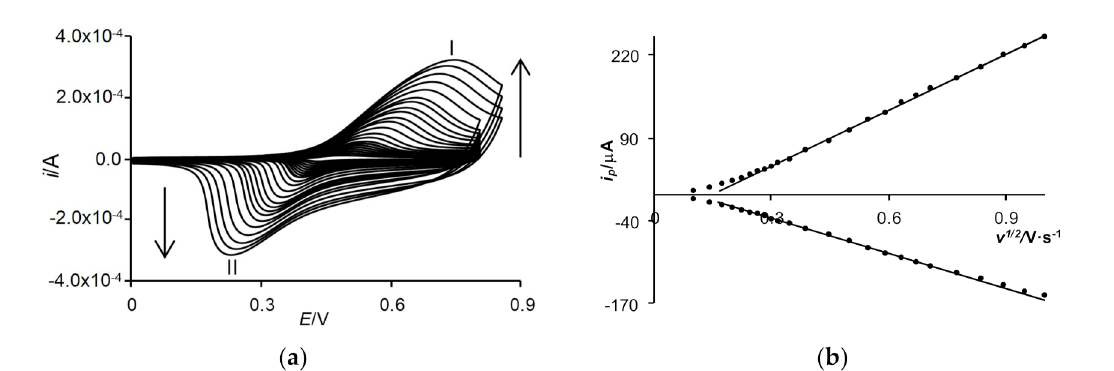
Figure 10. Poly [Ni(salcn(Me))] (15 electropolymerization cycles) in TBAClO 4 /CH 2 Cl 2 , Pt, v = 0.01–1 V · s − 1 , vs. Ag/AgCl; ( a ) cyclic voltammograms for one-step process, peak notations were used adequate to peak designation in a two-step process, see Figure 3; ( b ) plots i p vs. v 1/2 for oxidation and reduction processes. I and II—peaks labels.